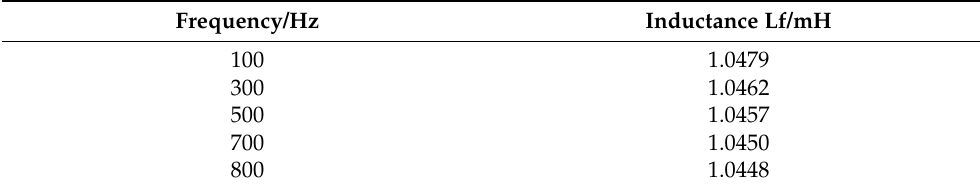
Table 2. The relationship between inductance and frequency